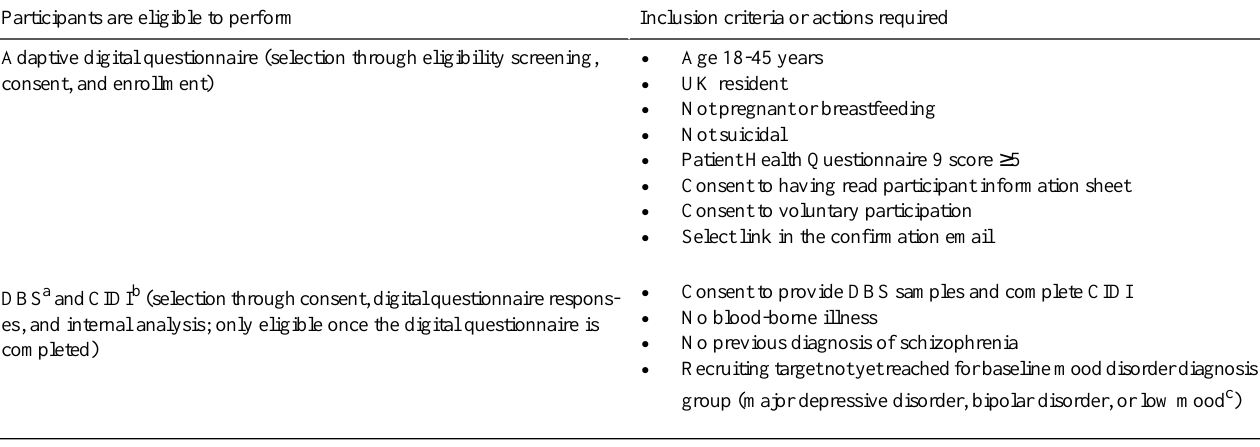
Table 1. Delta Trial inclusion criteria and consent